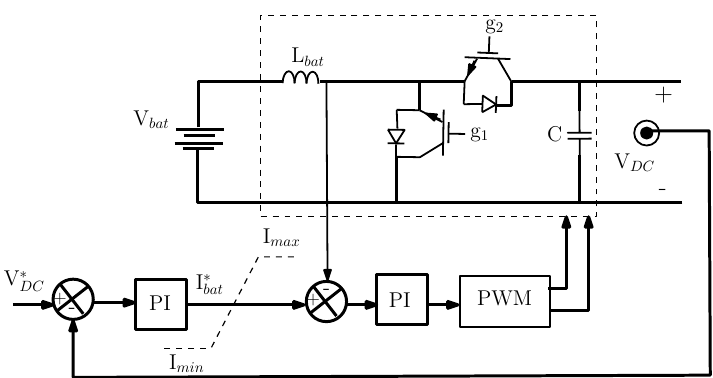
Figure 7. BESS and control structure.